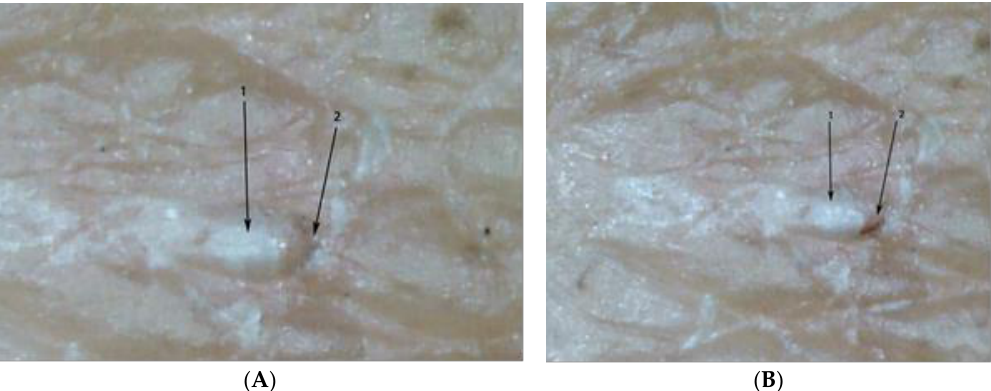
Figure 7. ( A ) Sarcoptes mite inside an acarine eminence with its dorsal part turned towards the surface of the skin (1); delta-wing sign visible (2); magnification 65-fold. ( B ) The same mite after having changed its position (1); now the ventral part is turned towards the surface of the skin (2); delta-wing sign not clearly visible.